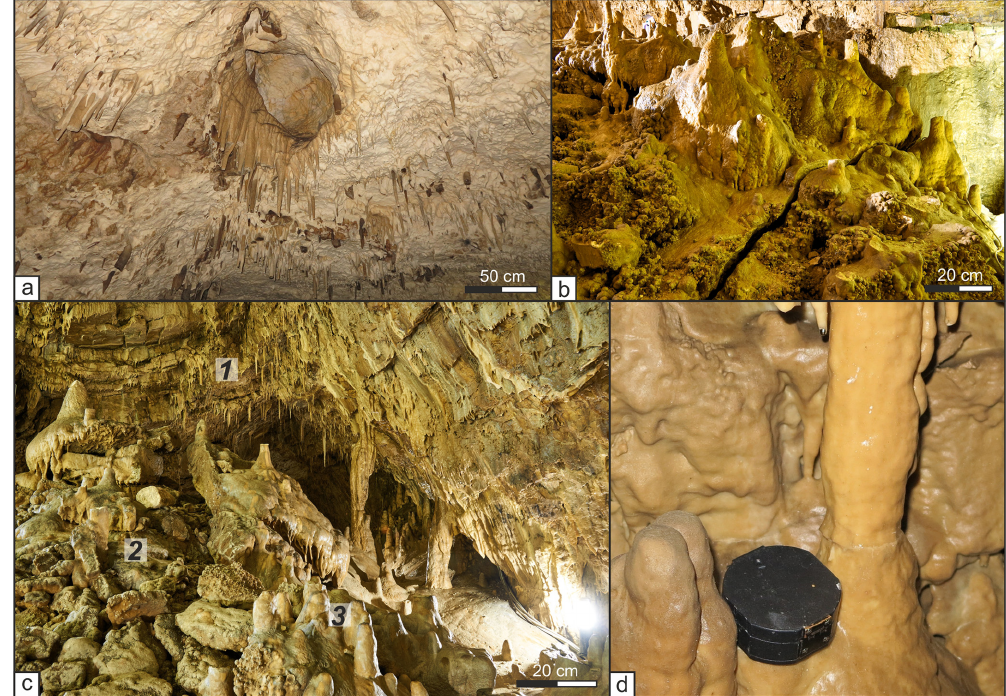
Figure 4. (a) Typical setting of the cave ceilings where originally “long” stalactites (probably more than 1m) are all truncated at the same point. Only short stalactites (tens of centimeters long) are entirely preserved. (b) Centimeter-wide sub-vertical open fractures frequently affecting flowstones, running at the base of the cave walls. (c) Centimeter- to decimeter-high stalagmites growing on top of collapsed materials: (1) ceiling rejuvenated by collapses, (2) blocks from the collapsed ceiling, and (3) stalagmites growth after the ceiling collapse. (d) Speleothem cuts along a sub-horizontal plane, with the upper part only translated from their original position but still standing upright. See Fig. 2d for site